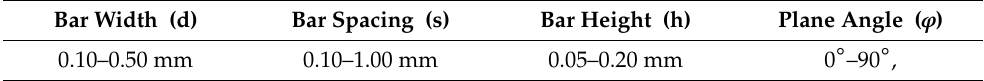
Table 1. Overview of the design variables (see Figure ?? ) and their variation ranges